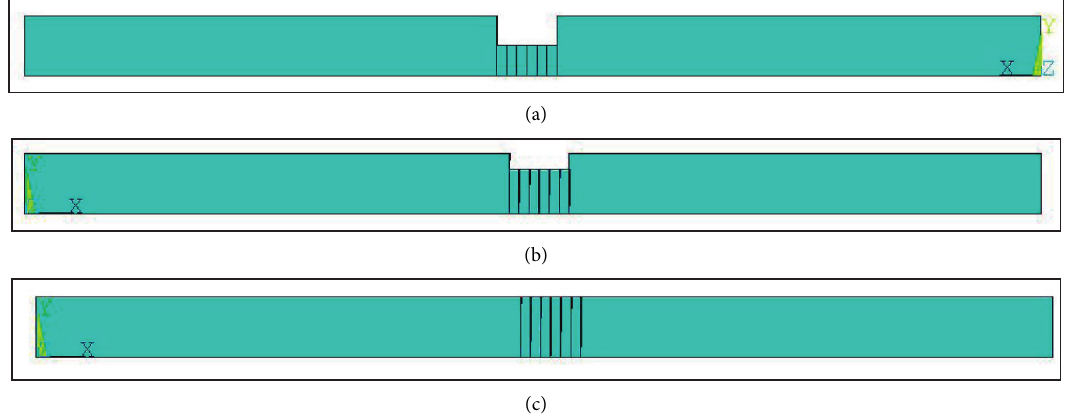
Figure 2: Simulation models for each pass. (a) Model for pass-1. (b) Model for pass-2. (c) Model for